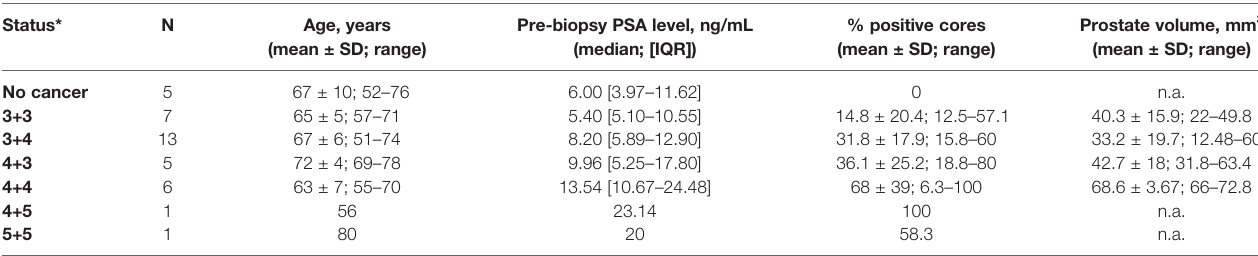
TABLE 1 | Patient characteristics and biopsy